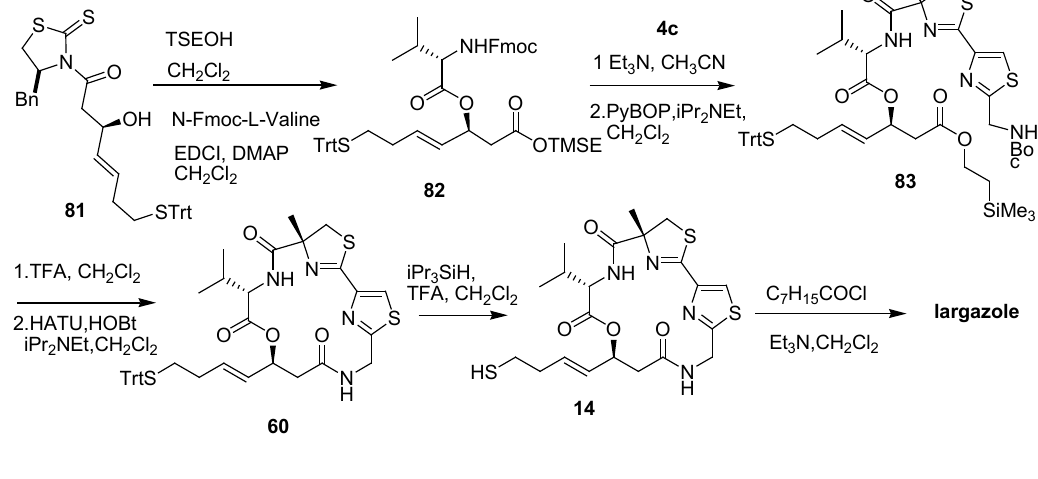
Figure 2. The structural modification pathways of